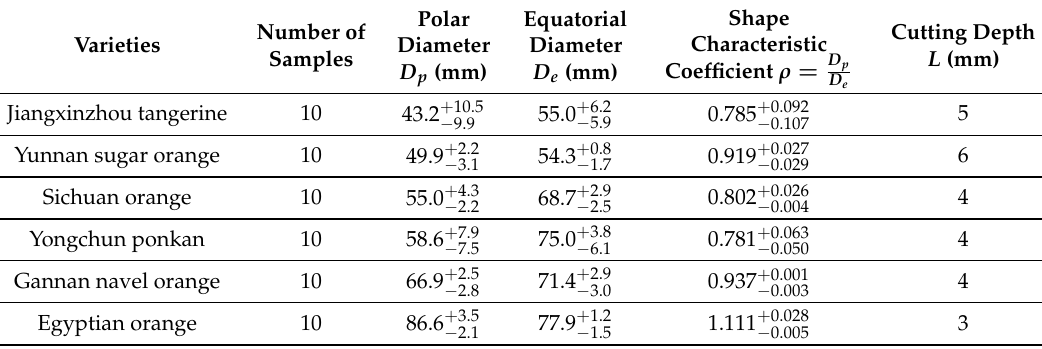
Table 2. Sphere section cut depth for each variety of